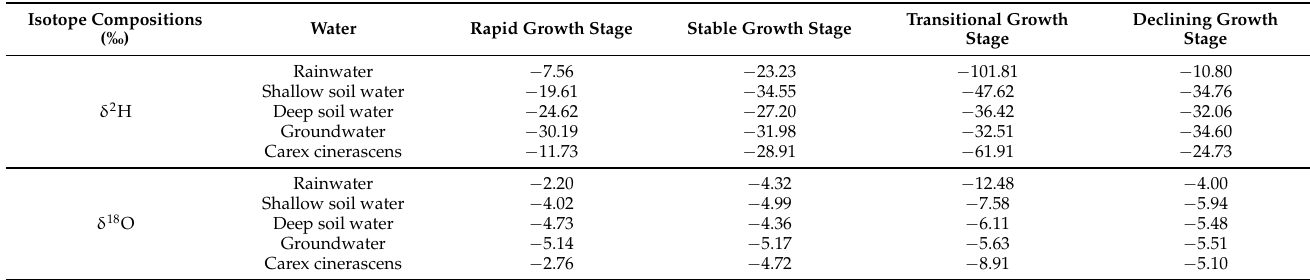
Table 2. Isotope compositions of water sources at different growth